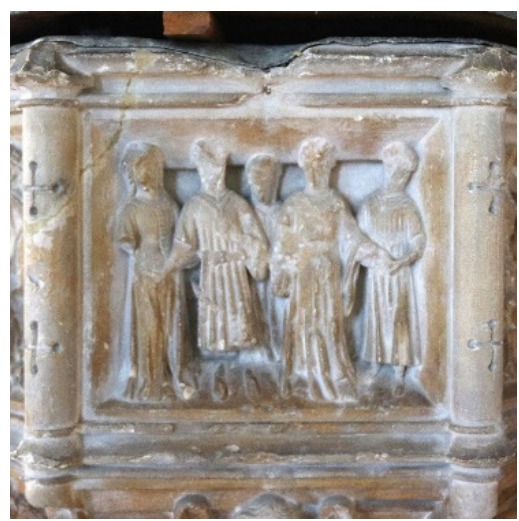
Figure 17. Matrimony. Source: Bob Mitchell.